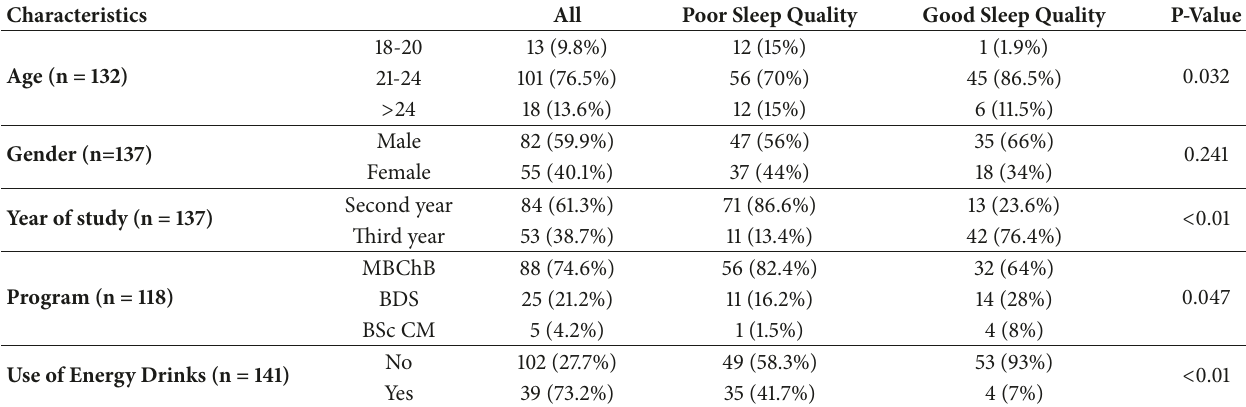
Table 1: Characteristics of the study